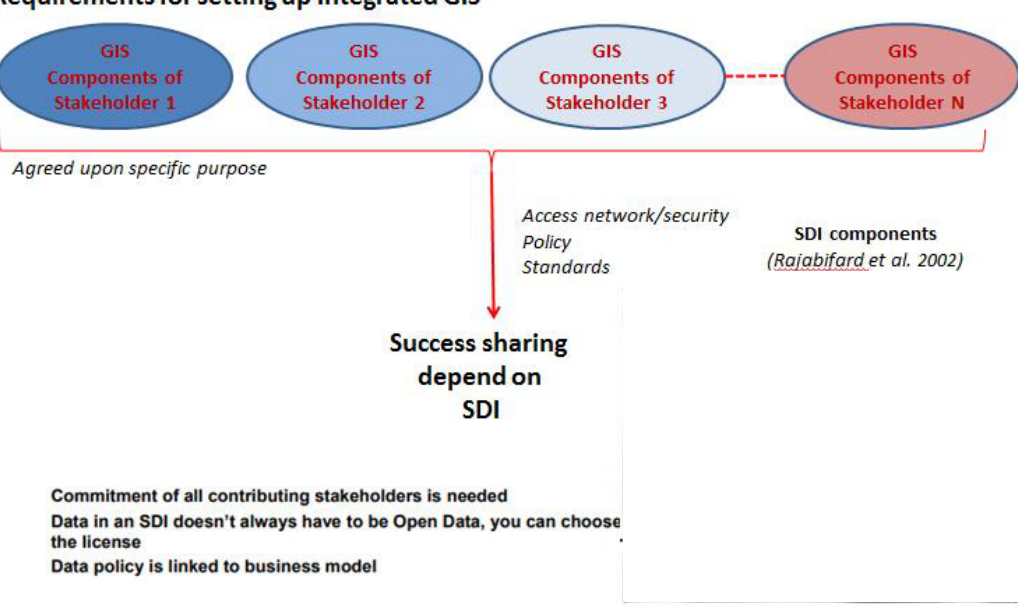
Figure 14: Requirement and flow for initiating integrated system with multiple stakeholders. (Rahabifard et al., 2002)